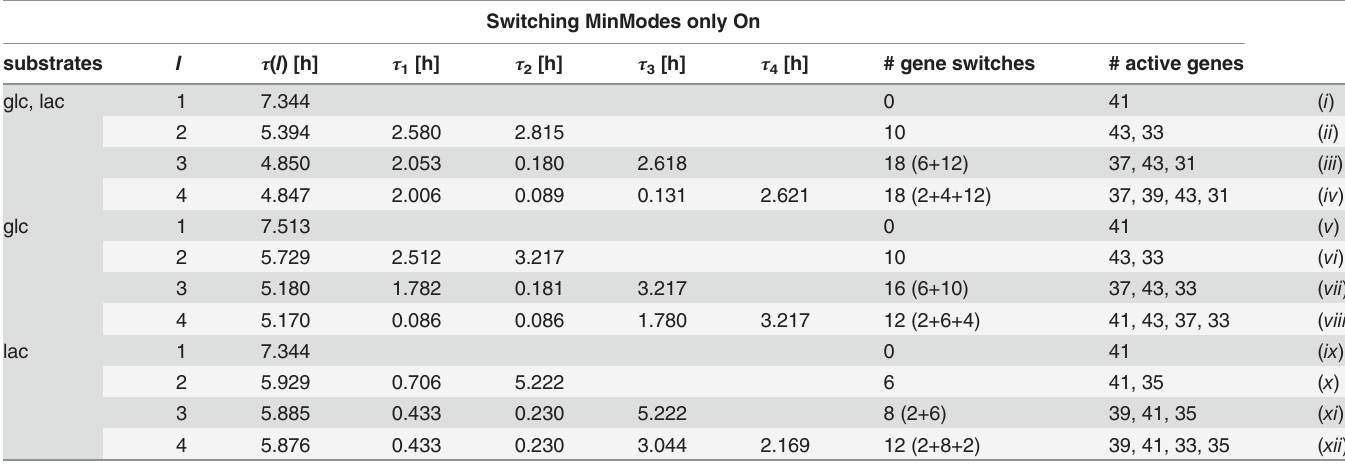
Table 4. Minimal production times if genes can only be switched on.